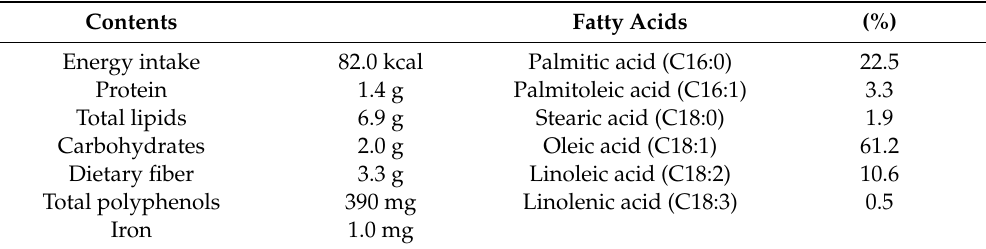
Table 1. Contents in 100 g of acai